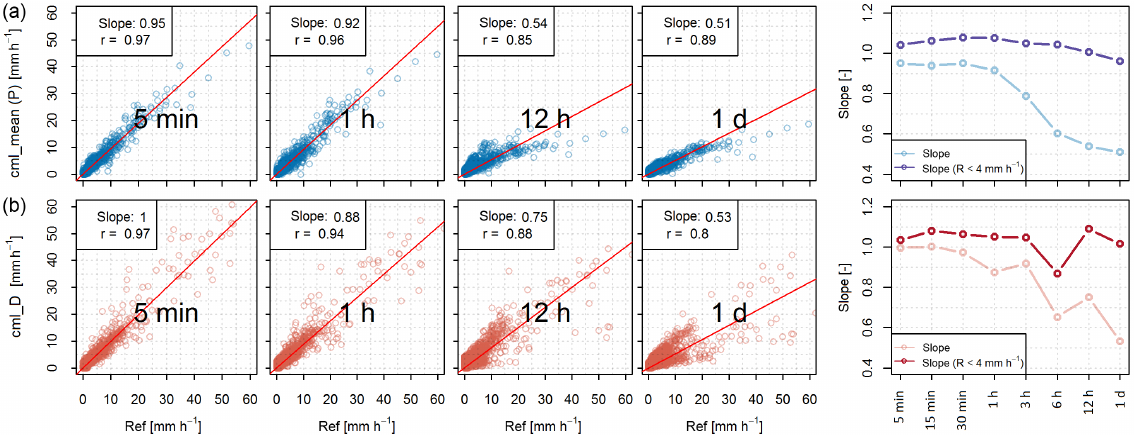
Figure 3. Comparison of CML QPEs adjusted by rainfall data of different time resolution to reference rainfall, from four averaged CMLs in Prague-Let ˇ nany (top panels) and one CML in Dübendorf (bottom panels). Scatter plots are shown only for selected aggregation intervals. Linear trend-line intersects are set to zero. Slopes of trend lines for all aggregation intervals are depicted in the right panels, showing also slopes of trend lines calculated for light rainfalls ( R < 4mmh − 1